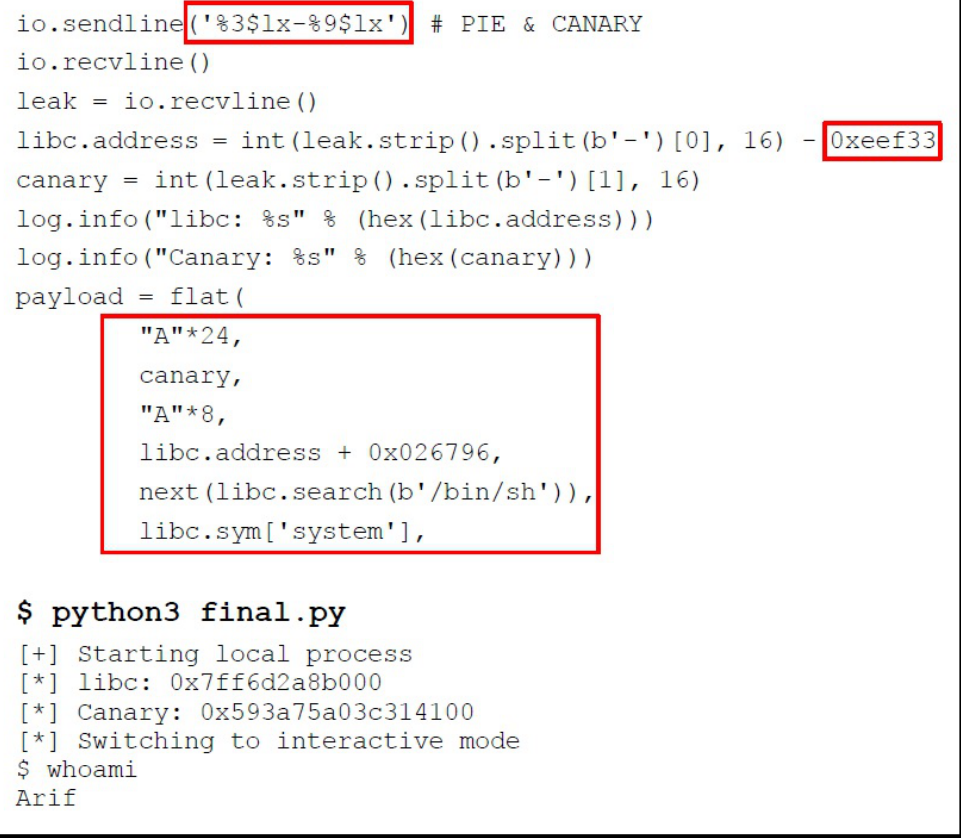
Figure 34. Crafting